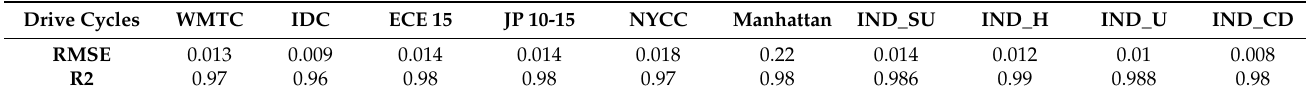
Table 4. RMSE and R 2 values when LVQNN tested for various drive